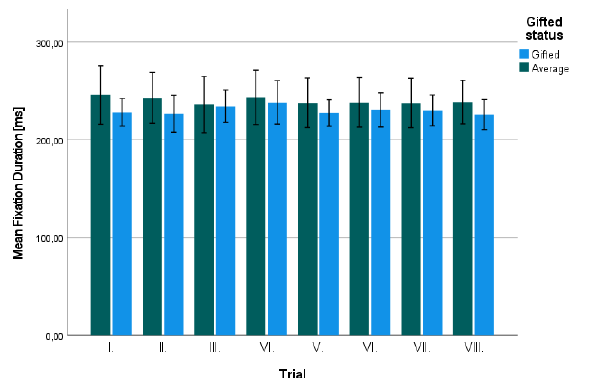
Figure 5. Regression rate in gifted and average children across individual trials. Error bars mark 95%